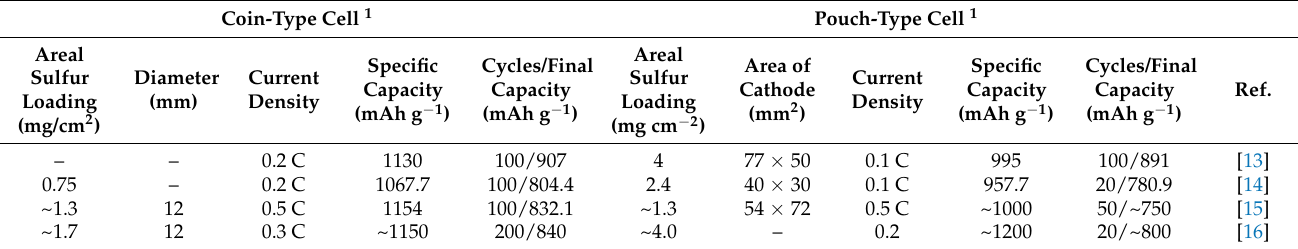
Table 1. Current status of Li–S coin cell and pouch cell electrochemical performances. Coin-Type Cell 1